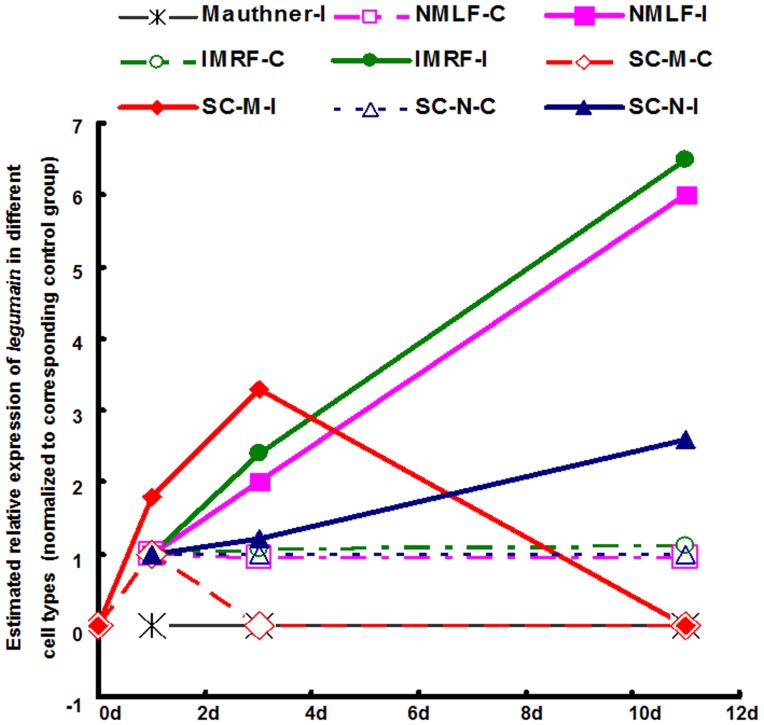
Summary scheme of legumain expression patterns in distinct cell types in brain and spinal cord after SCI.No signal for legumain expression was set as 0. When signal for legumain is detected in sham-injured control at 1 day post-injury, the value for legumain expression in 1 day sham-injured control is set as 1 and the relative expression in all other groups is normalized to the 1 day sham-injured control. The expression of legumain in brainstem neurons (NMLF-I, IMRF-I) is increased sharply after 1 day post-SCI. Legumain in spinal cord neurons (SC-N-I) is increased only at 11 days post-SCI. In the sham-injured control group, legumain expression in macrophages/microglia in the caudal spinal cord (SC-M-C) is detectable at 1 day and no more detectable thereafter. In the SCI group (SC-M-I), legumain expression in macrophages/microglia is increased 1 day, reaches a peak at 3 days and disappears 11 days after SCI. Abbreviations: Mauthner-I, Mauthner neurons of the SCI group; NMLF-C, NMLF neurons of the sham-injured control group; NMLF-I, NMLF neurons of the SCI group; IMRF-C, IMRF neurons of the sham-injured control group; IMRF-I, IMRF neurons of the SCI group; SC-M-C, macrophages/microglia in the caudal spinal cord of the sham-injured group; SC-M-I, macrophages/microglia in caudal spinal cord of the SCI group; SC-N-C, neurons in caudal spinal cord of the sham-injured group; SC-N-I, neurons in caudal spinal cord of the SCI group.